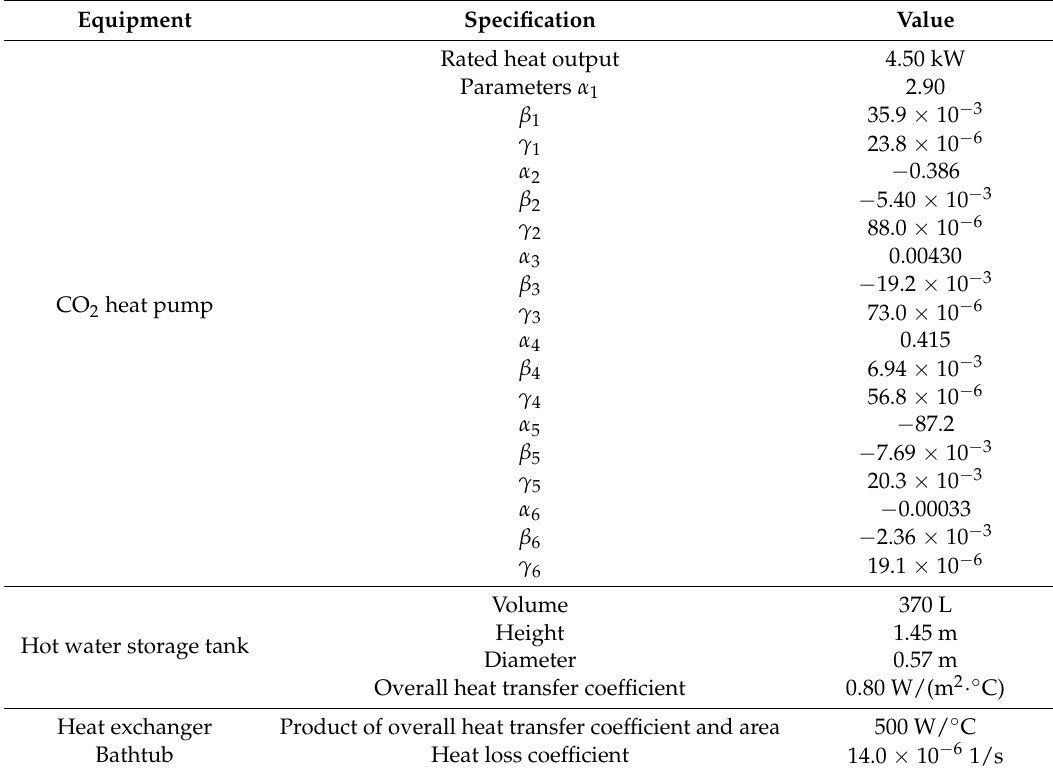
Table 2. Specifications of CO 2 heat pump water heating